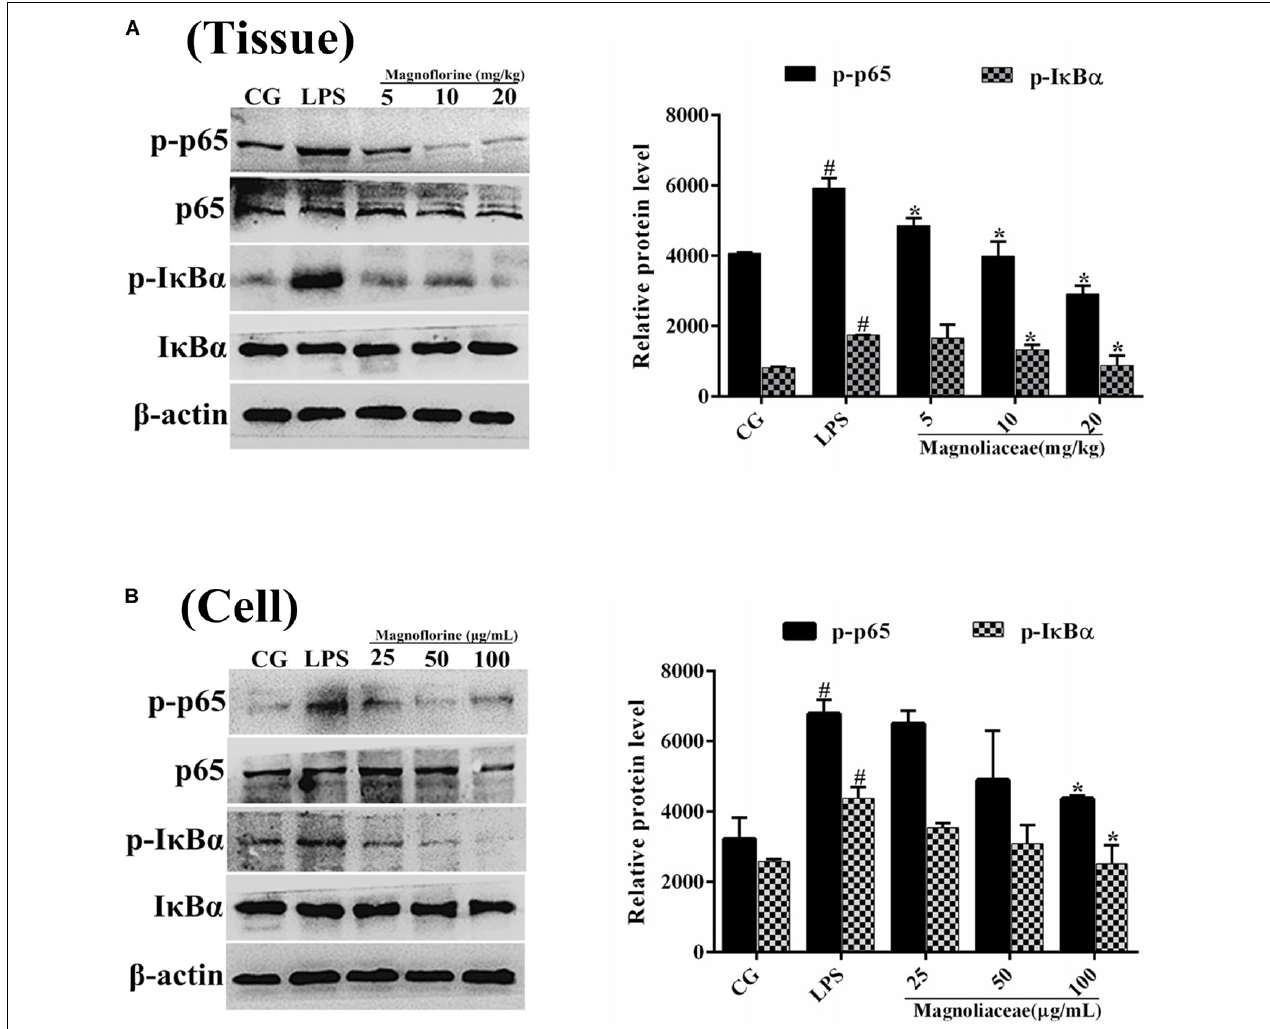
FIGURE 6 | The effects of magnoflorine on the NF- κ B pathway activation. (A) The expression levels of I κ B α and p65 proteins were analyzed using specific antibodies in lung tissues. (B) The expression levels of I κ B α and p65 proteins in RAW264.7 cells. β -actin was used as the control. CG is the control group. LPS is